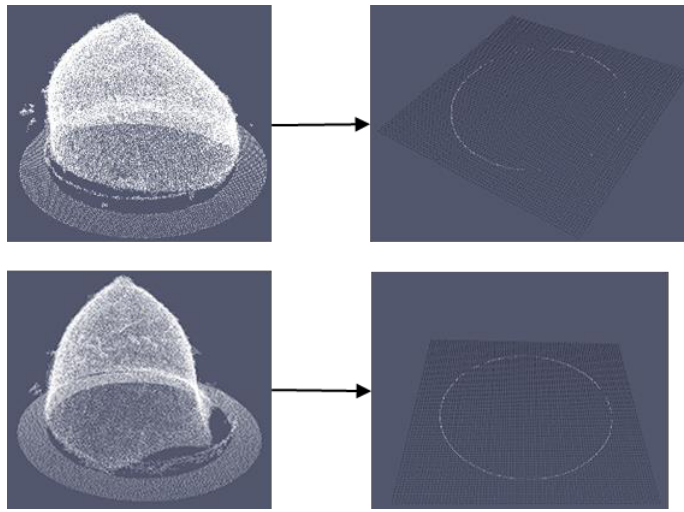
Figure A7. Verification procedure after ring removal. The white points on the flat grid (the right-hand images) correspond to the remaining ring points.